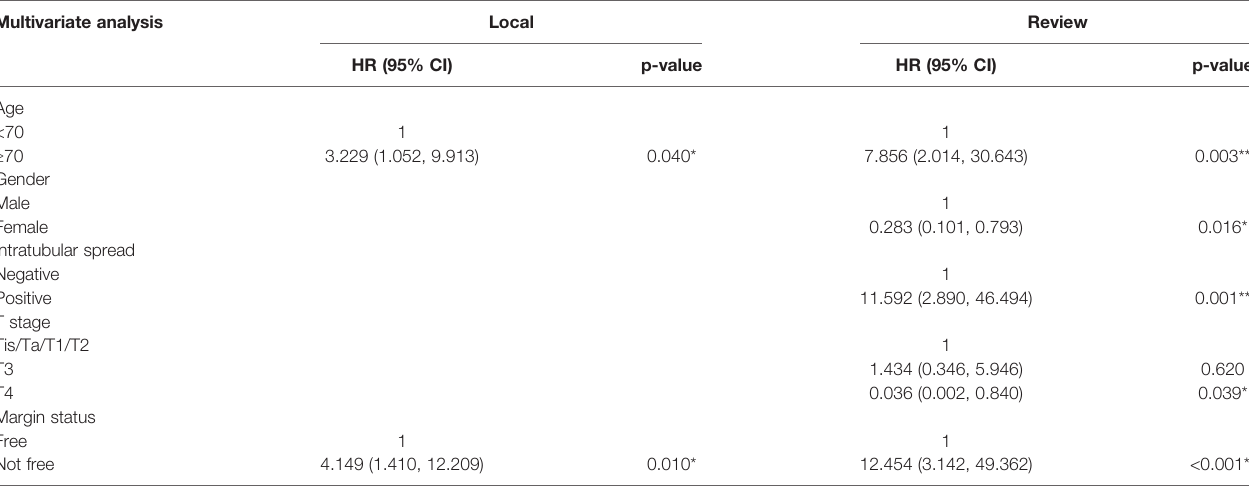
TABLE 8 | Comparative multivariate disease-free survival analysis of upper tract urothelial cancer. Multivariate analysis